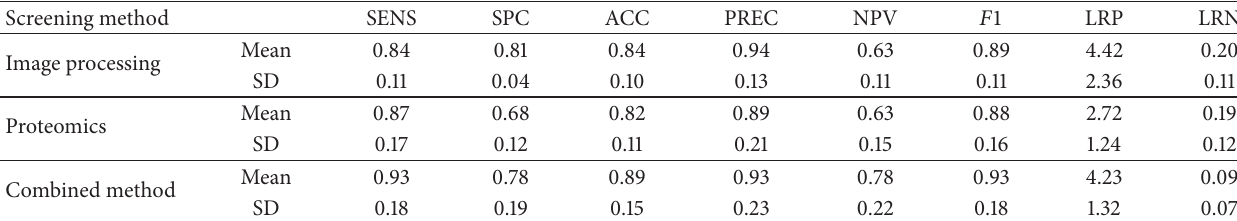
Table 2: Performance measures of the screening methods.